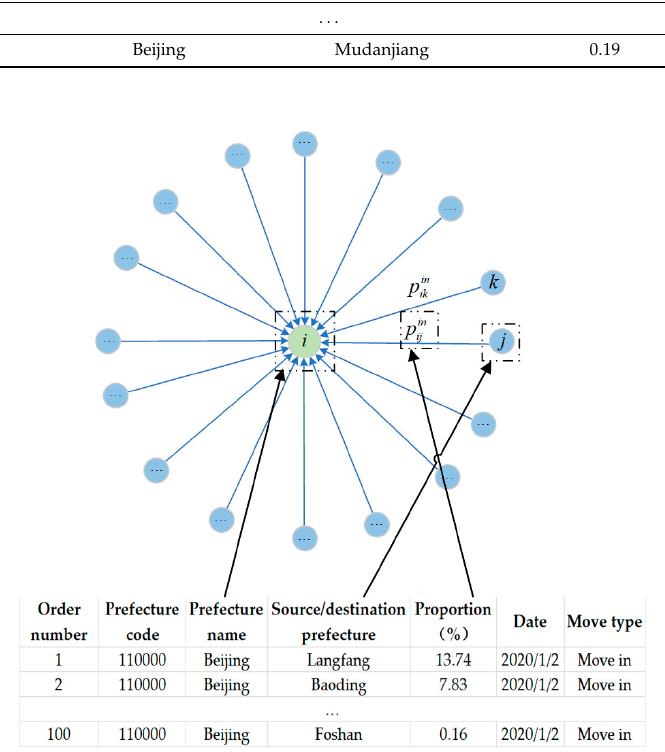
Figure A1. Schematic diagram of converting the migration proportion data of prefecture into a star network.